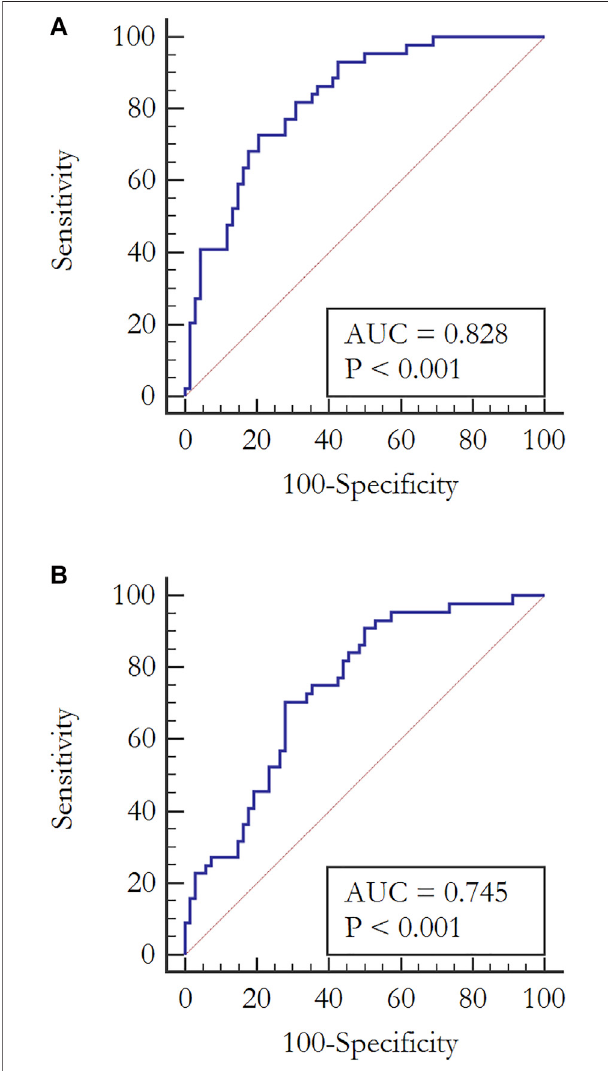
FIGURE 2 | ROC curves analyses evaluating the clinical usefulness of potential biomarkers to diagnose pregnant women with aGT – group from a fasting serum sample in the second trimester. (A) Combination of α – HB, β – HB, and myristic acid: AUC (cid:1) 0.828, CI (0.745 – 0.892), Sensitivity (cid:1) 72.7,Speci fi city (cid:1) 79.4, p < 0.0001 (B) α – HB:AUC (cid:1) 0.745,CI(0.654 – 0.823), Sensitivity (cid:1) 70.5, Speci fi city (cid:1) 72, p <